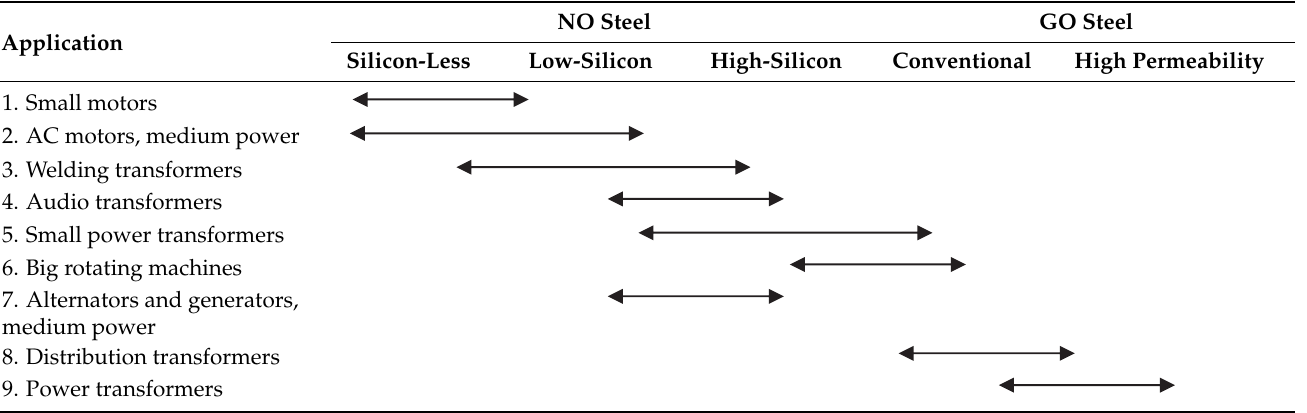
Table 1. Applications of electrical steels. Table 1 schematically depicts the applications of electrical steels.